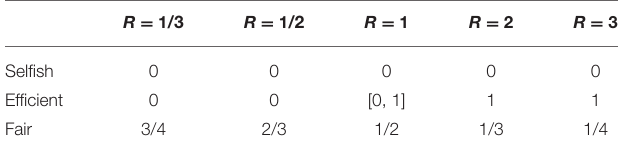
TABLE 1 | Predicted GR for the three dimensions. R = 1 /3 R = 1 /2 R = 1 R = 2 R = 3 Selfish 0 0 0 0 0 Efficient 0 0 [0, 1] 1